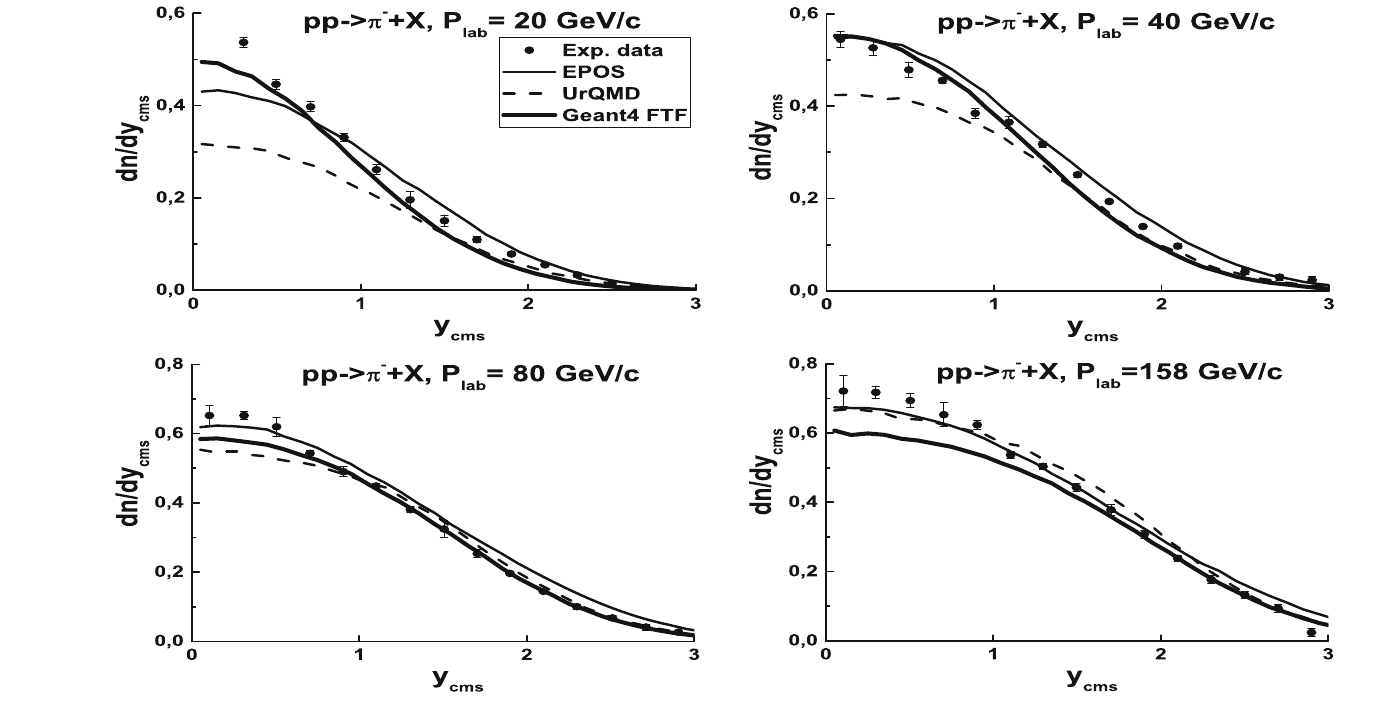
The dashed lines are the UrQMD calculations. The thick solid lines are the Geant4 FTF model calculations